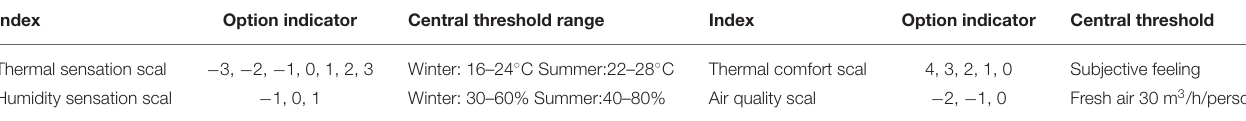
TABLE 3 | Thermal environment questionnaire